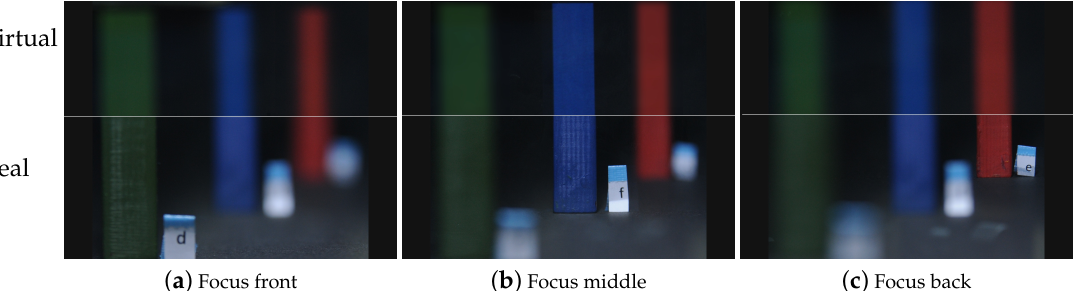
Figure 7. Limitation of our prototype: as the distance to the virtual image plane coincides with the blue pillar, it is the only pillar that can be rendered with only minor artifacts. Note how the red and green pillars exhibit noticeably greater artifacts. The top row shows all virtual pillars, while the bottom row only shows real